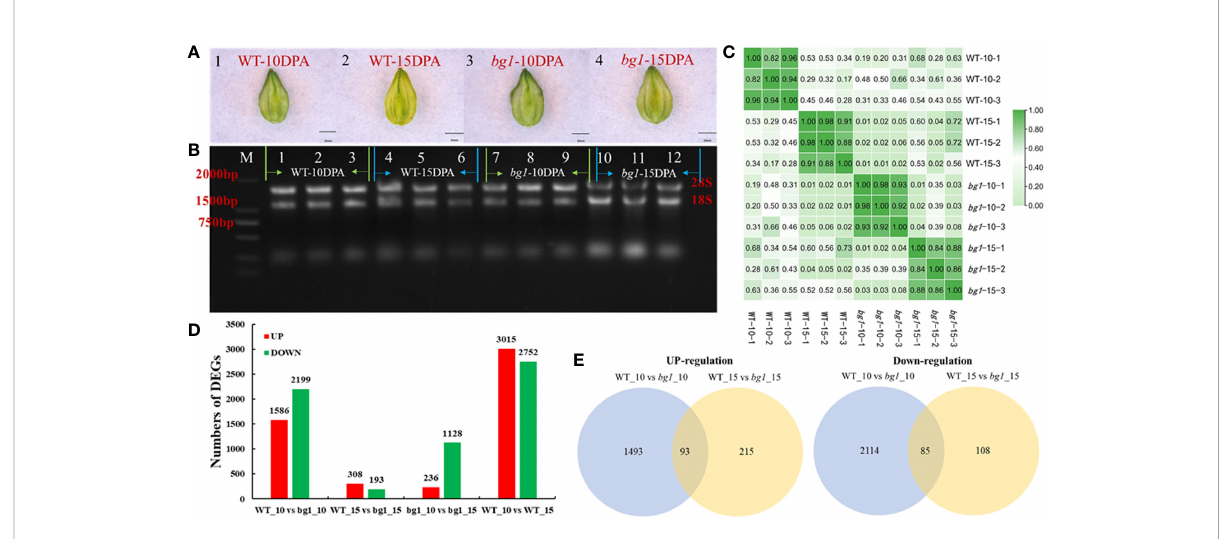
FIGURE 2 Transcriptome sequencing and analysis of DEGs in Tartary Buckwheat. (A) Morphological observation of sampled grains. (B) Results of agarose electrophoresis of total RNA from samples. (C) Correlation analysis between samples. (D) The number of up-and down-regulated differentially expressed genes in different comparisons. (E) Venn diagram of differentially expressed genes.